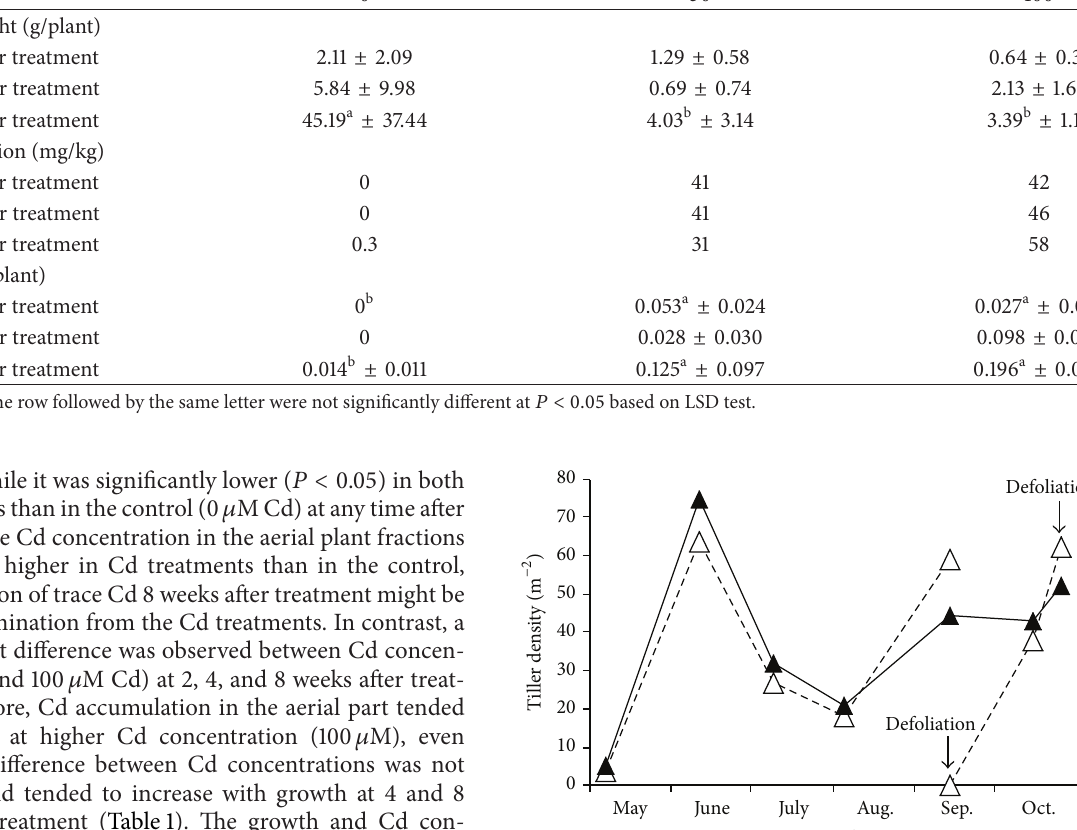
Table 1: Changes in cadmium (Cd) concentration and uptake of Napiergrass plants grown in Cd-containing hydroponic conditions in 2010. Parameter